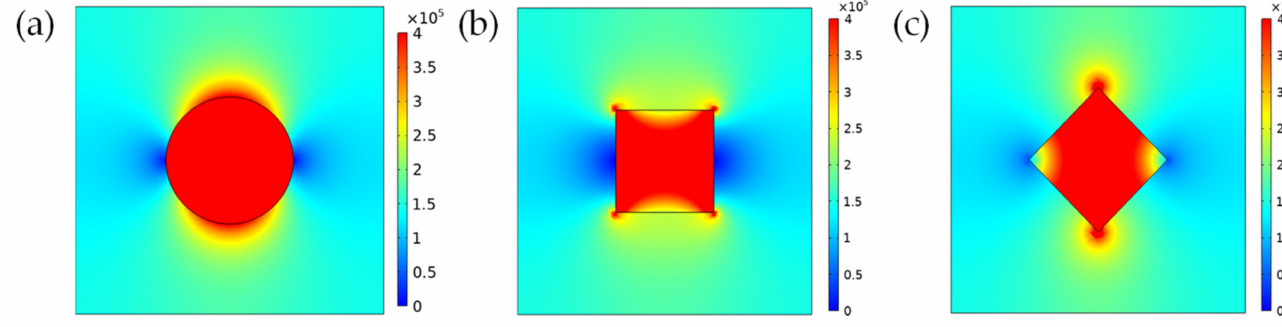
Figure 12. Cross-section conductive heat flux cloud diagram of composite materials. ( a ) Filler particle is small sphere; ( b ) Filler particle is horizontally placed cube; ( c ) Filler particle cube is rotated 45 ◦